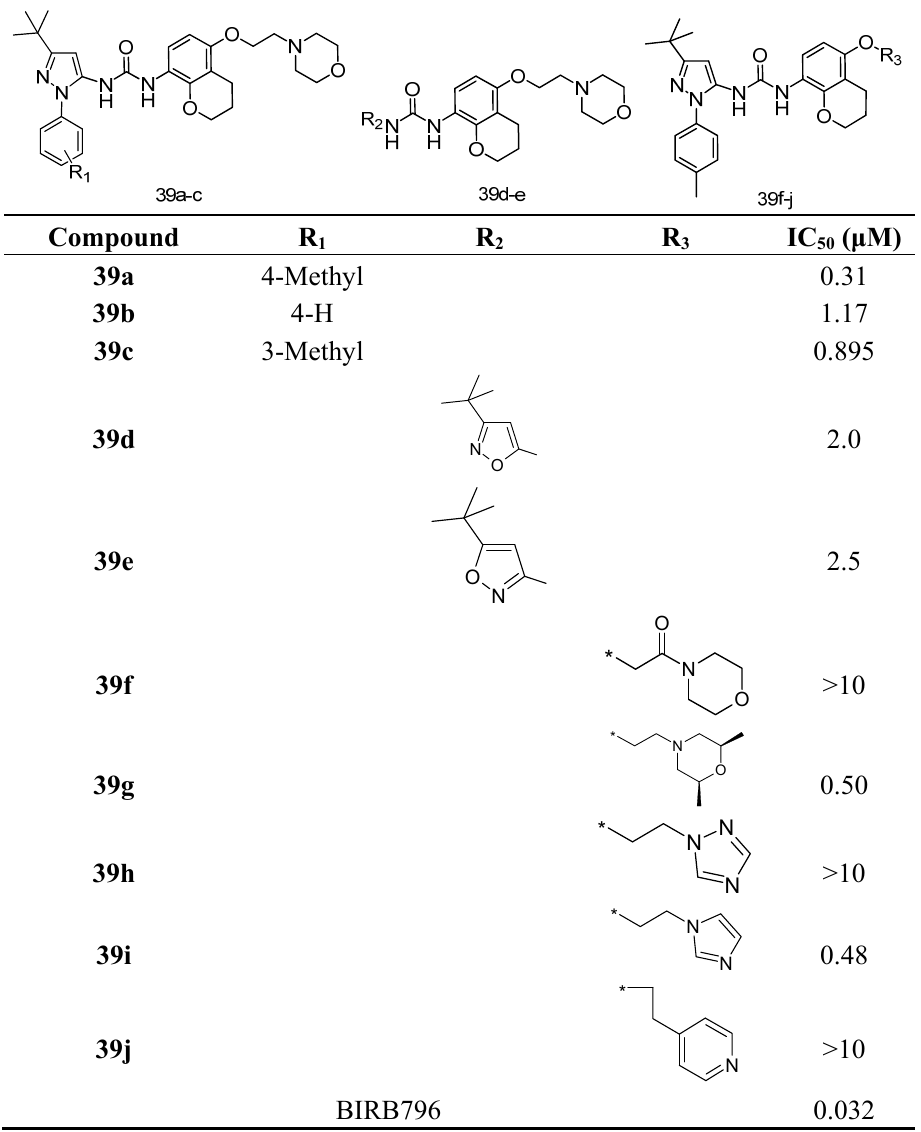
Table 2. Structure and TNF- α inhibitory activity of 1-aryl-3-(chroman-5-yl)urea compounds 40a – i